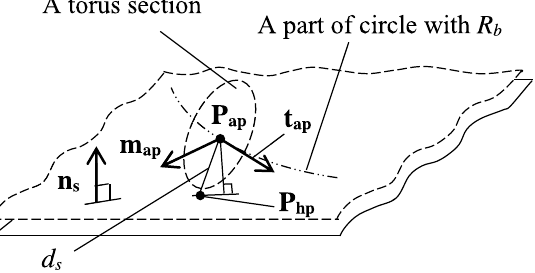
Fig. 8. Some variables associated with a